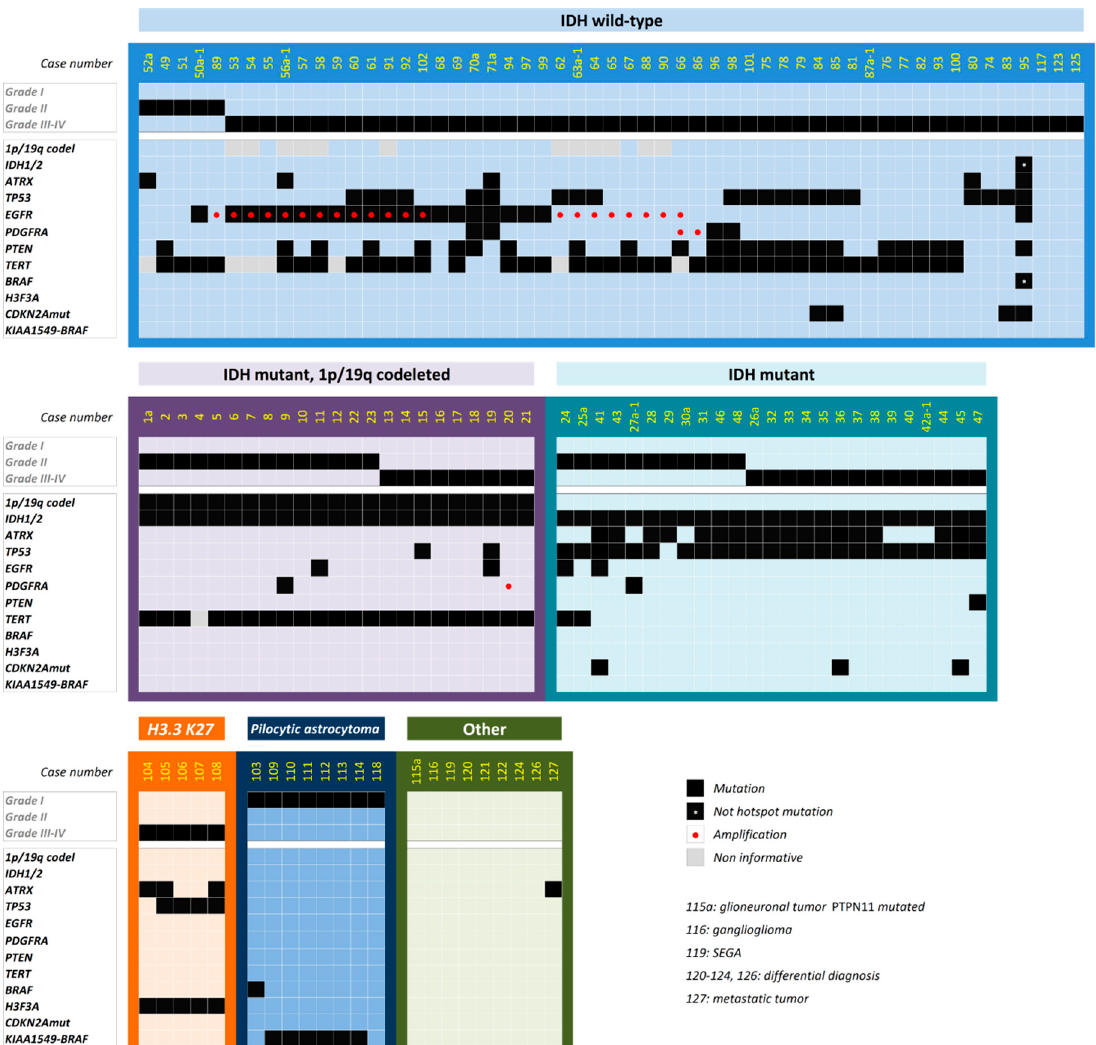
Figure 2. Genomic alterations identified in the whole series. Samples (columns) are grouped by 2016 World Health Organization (WHO) criteria. The WHO grade and somatic mutations are indicated by black squares.